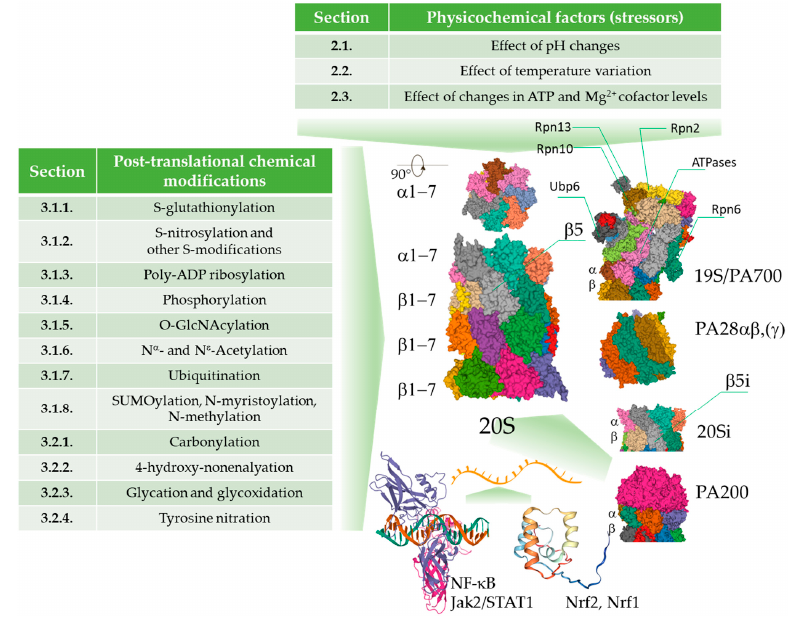
Figure 1. An overview of the physico-chemical effects of the cellular environment on the function of the proteasome. The activity of the proteasome can be modulated by pathological and physiological pH and temperature fluctuations, changes in the levels of cofactors, reversible and irreversible covalent modifications leading to modulation of performance of the proteasomal complexes, or irreversible damage of those complexes. The changes promoted by the physico-chemical stressors can be compensated by de novo synthesis of the proteasome subunits. Images are from the RCSB PDB (rcsb.org) of PDB ID: 6RGQ [64,65], 5A5B [65,66], 5MX5 [65,67], 6E5B [65,68], 6KWY [65,69], 2RAM [65,70], 2LZ1